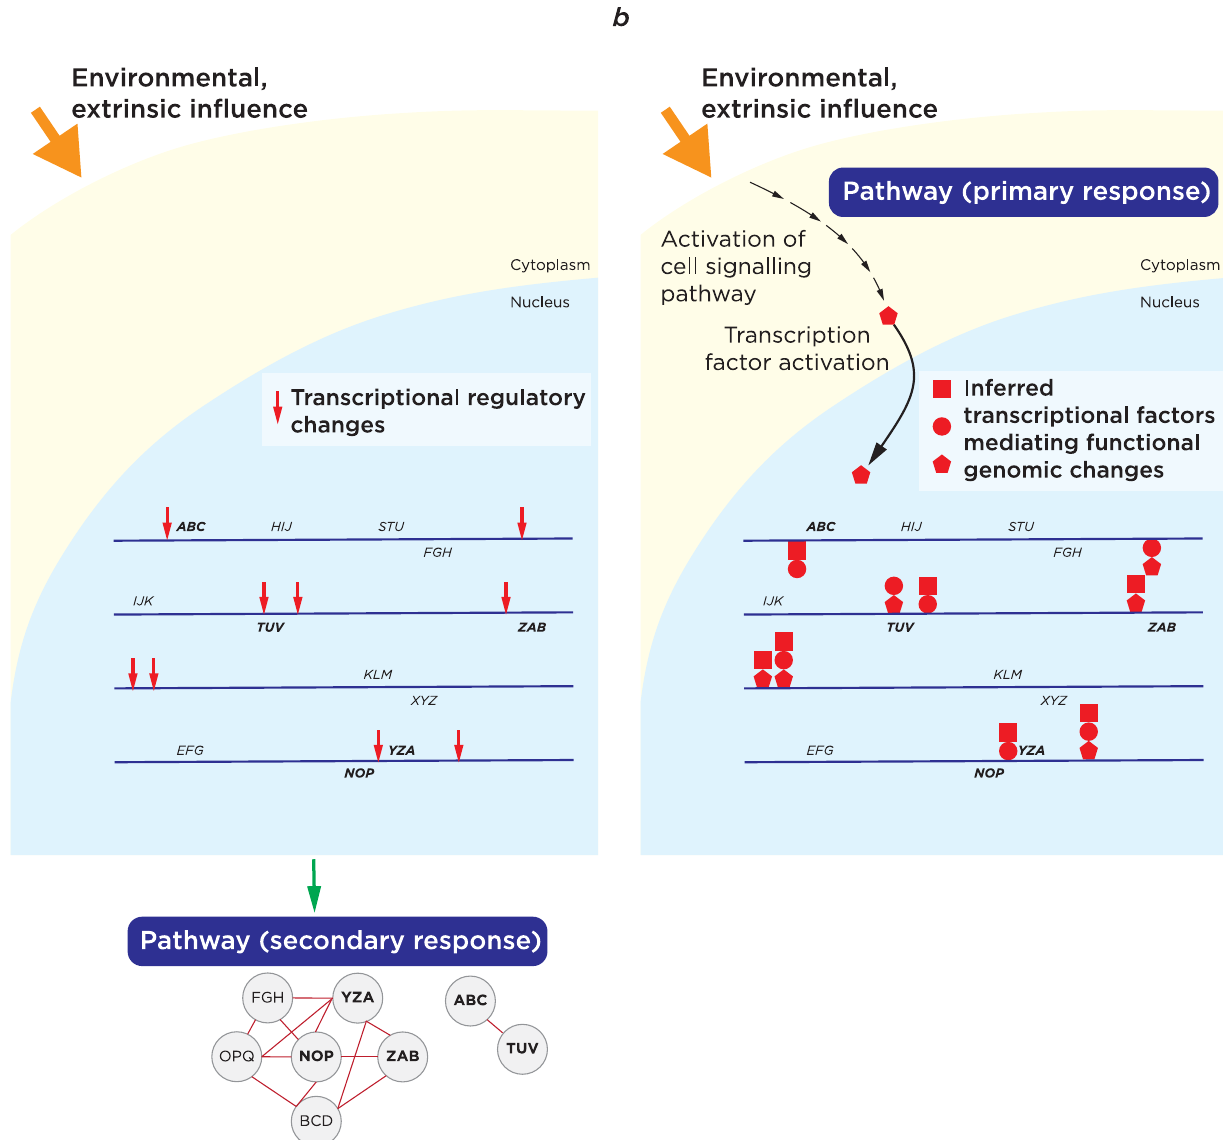
Fig 6. ( a ) When testing the response to an extrinsic influence using genomic approaches, we typically identify the loci at which changes are most pronounced and attempt to understand how they have biological coherence by studying the genes implicated for their biological properties, including protein–protein interactions. While this is part of the cellular response to the extrinsic perturbation, an alternative perspective is shown in ( b ), considering the role of TFs to select loci for altered function and, in turn, the cell signalling pathways that regulate the TFs. The activation of TFs in this model would be the primary response to the extrinsic influence, with the transcriptional regulatory changes a secondary